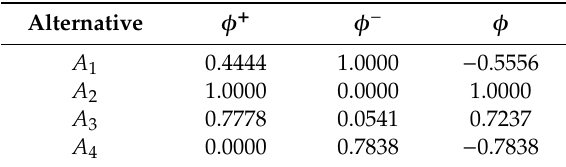
Table 2. The inflow, outflow and net